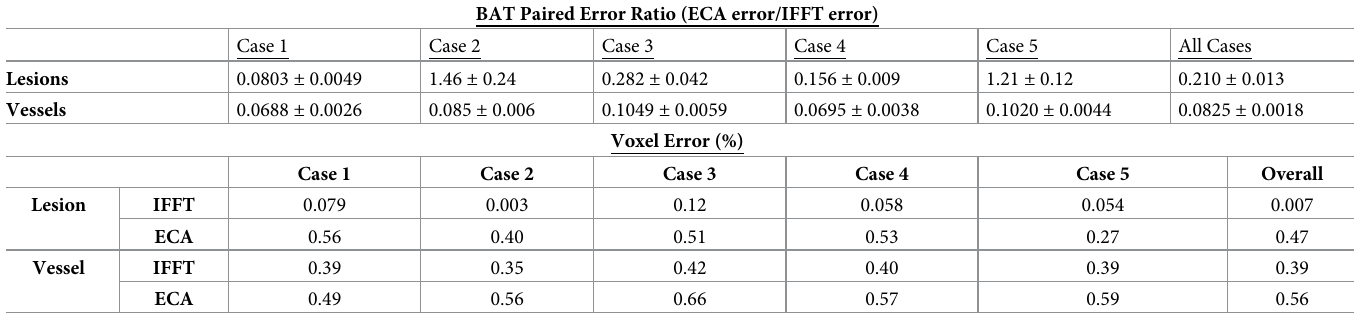
Table 3. Summary statistics for BAT and voxel intensity errors in ECA and IFFT